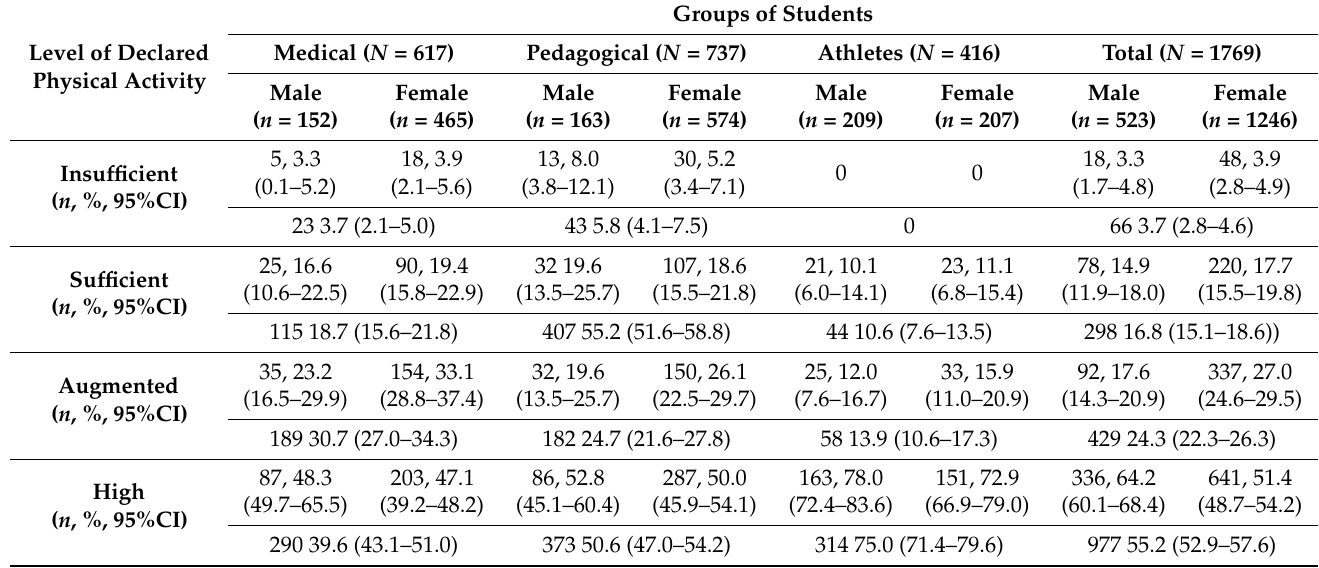
Table 3. Declared level of physical activity by future profession and